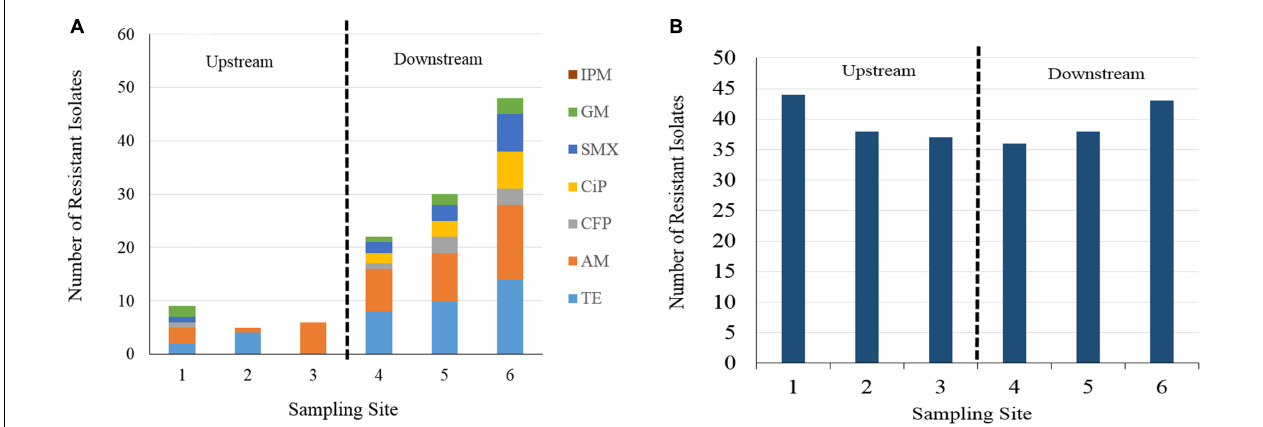
FIGURE 2 | (A) Number of resistant isolate responses to seven of eight antibiotics at different sampling site by Kirby Bauer disc diffusion method. Cephalothin is excluded for visibility of less frequently occurring AB resistances. IPM, imipenem, GM, gentamycin, SMX, sulfamethoxazole, CiP, ciprofloxacin, CFP, cefoperazone, AM, ampicillin, TE, tetracycline. (B) Column chart of cephalothin resistant E. coli isolate responses. Resistance occurred at a greater frequency than other antibiotic resistances, more consistently across upstream and downstream sampling sites.